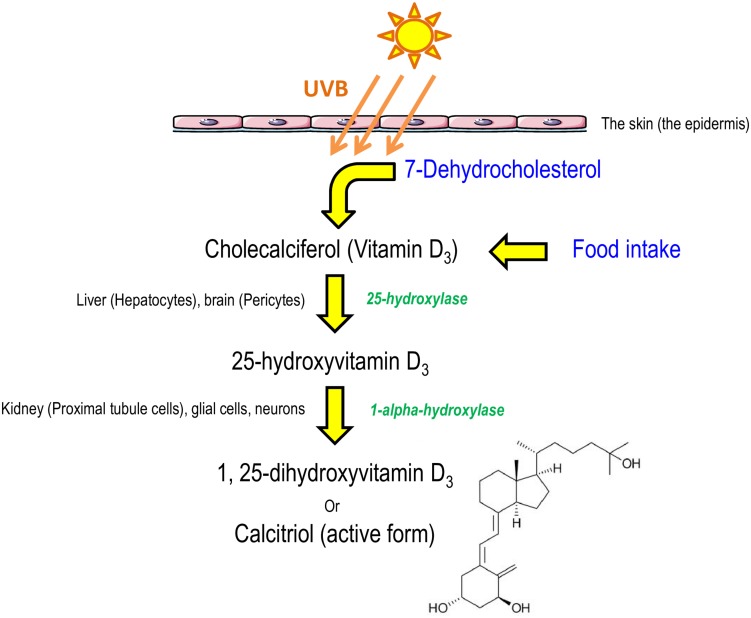
Schematic representation of calcitriol synthesis in humans. Cholecalciferol, from food intake or derived from 7-dehydrocholesterol after sun exposition, is converted to calcitriol, the active form, by two hydroxylations (Emmanuel et al., 2002; Eyles et al., 2005; El-Atifi et al., 2015).